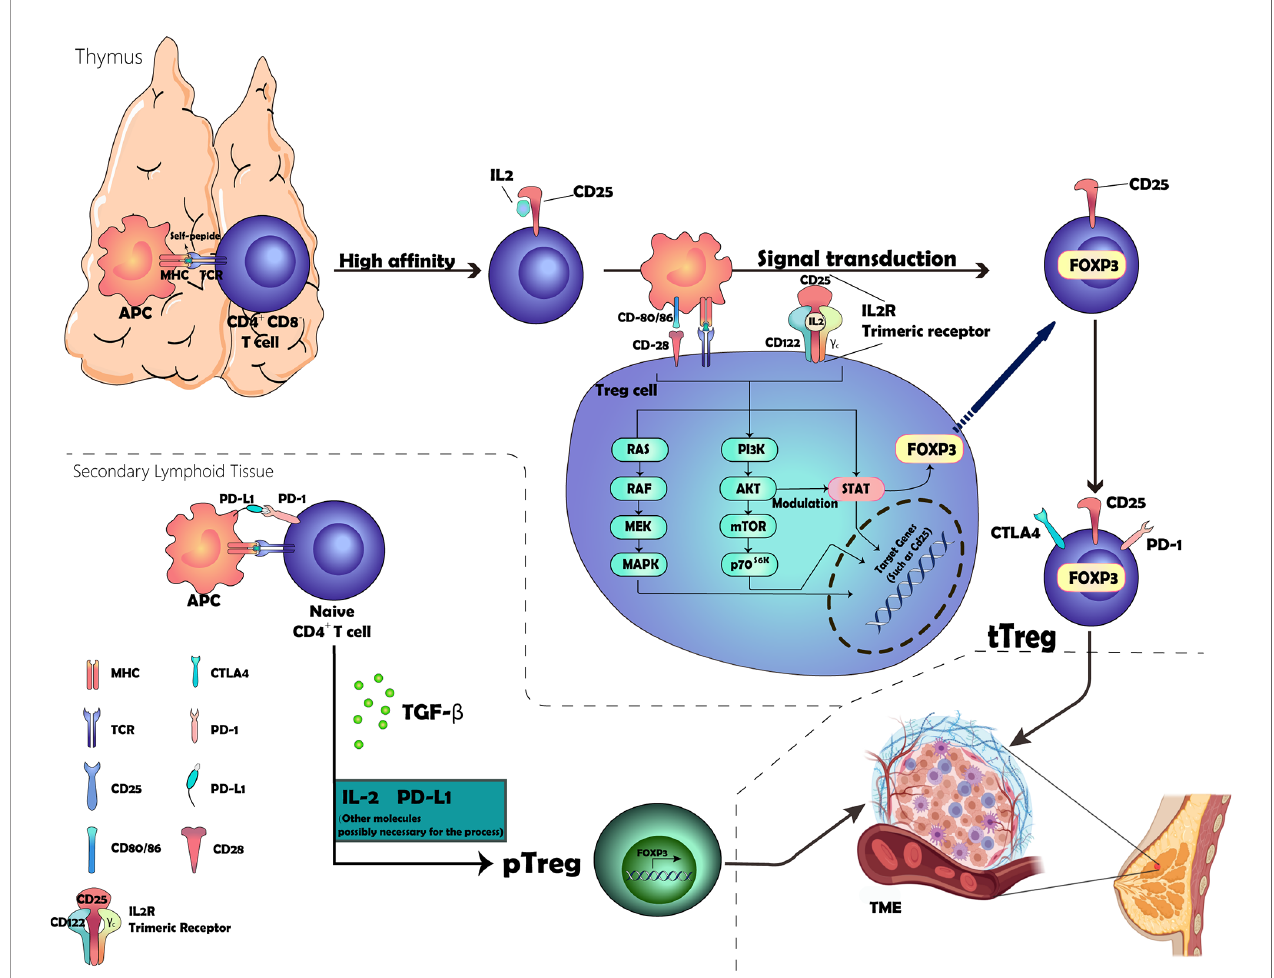
FIGURE 2 | Detailed process of lymphocyte in fi ltration in a breast cancer